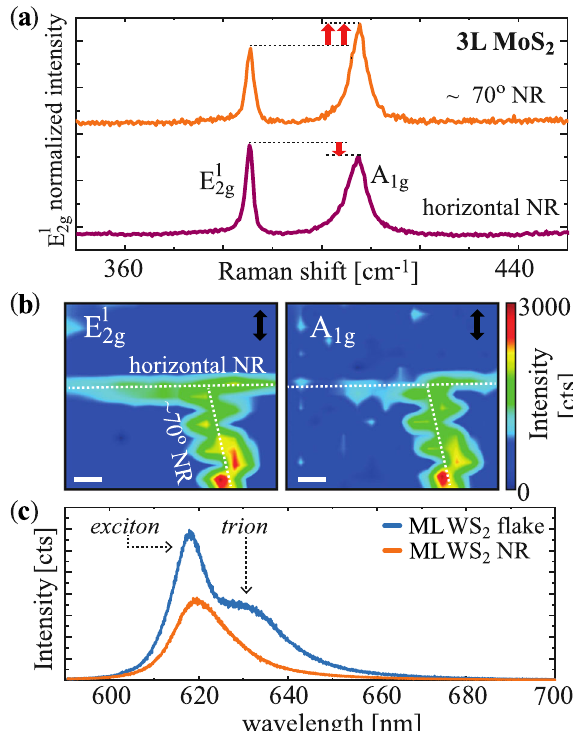
Fig. 2 Evidence of structural integrity of the NRs. a Raman spectra of the characteristic vibrational modes of MoS 2 showing the tri-layer fl ake before patterning, and two ribbons with ≈ 70 ∘ of relative inclination. The spectra are normalized with respect to the E 1 -mode 2 g intensity, and relative changes of the A 1 g mode are indicated by horizontal dashed lines and red arrows. b Raman intensity maps of E 1 and A 1 g modes of two intersecting NRs (scale-bar: 0.5 μ m), 2 g highlighting a distinct variation of A 1 g mode as the ribbon direction is changed. The direction of linearly polarized light is indicated by black arrows. This is in agreement with the published result that the peaks is strongly dependent on relative intensity of the A 1 g to E 1 2 g the orientation angle of the material ’ s crystallographic axes, for a fi xed in-plane polarization 60 . c PL spectra of a ML WS fl ake and 2 corresponding NR, highlighting exciton and trion